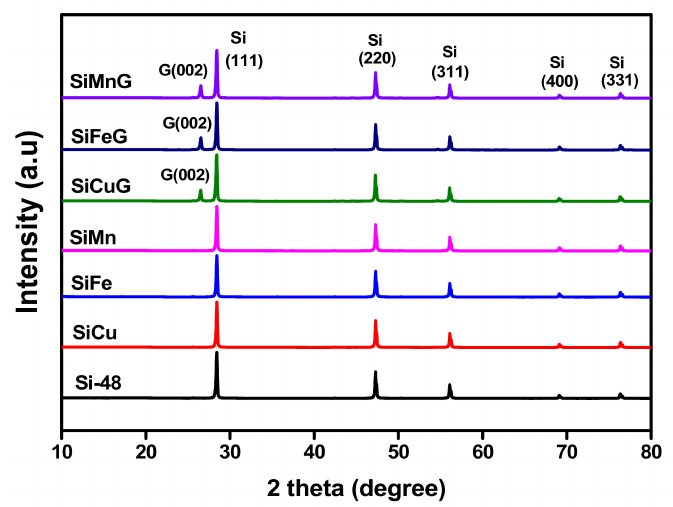
Figure 2. XRD patterns of Si-48, SiCu, SiFe, SiMn, SiCuG, SiFeG, and SiMnG materials.